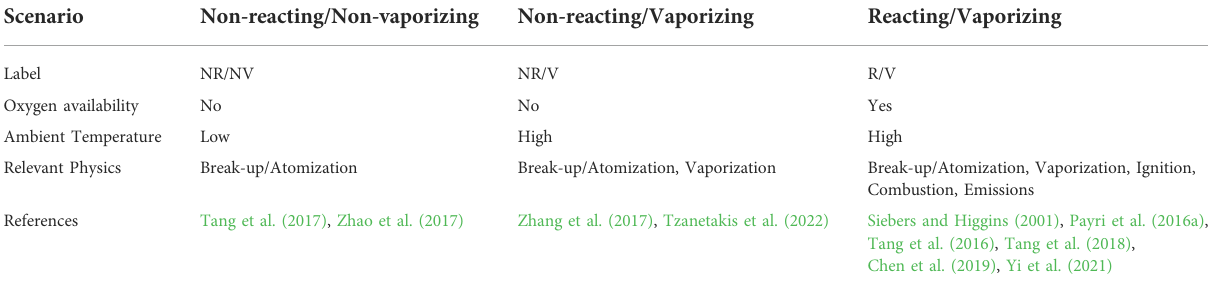
TABLE 2 Various experimental scenarios for spray